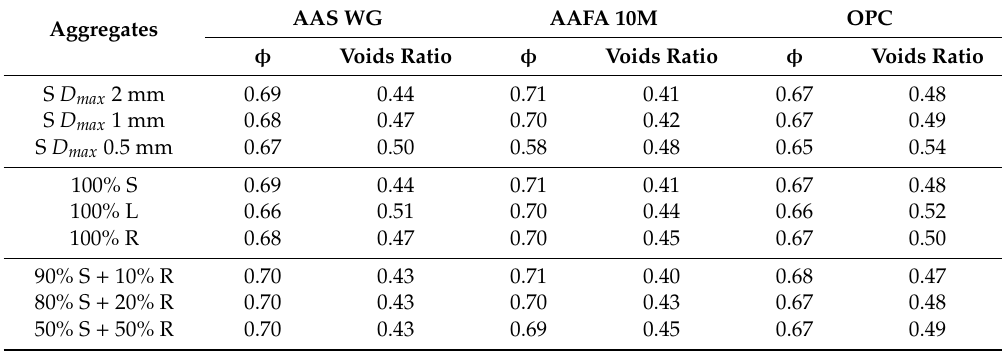
Table 7. Packing density ( φ ) and voids ratio in AAS-WG, AAFA-10M, and OPC mortars by aggregate size and